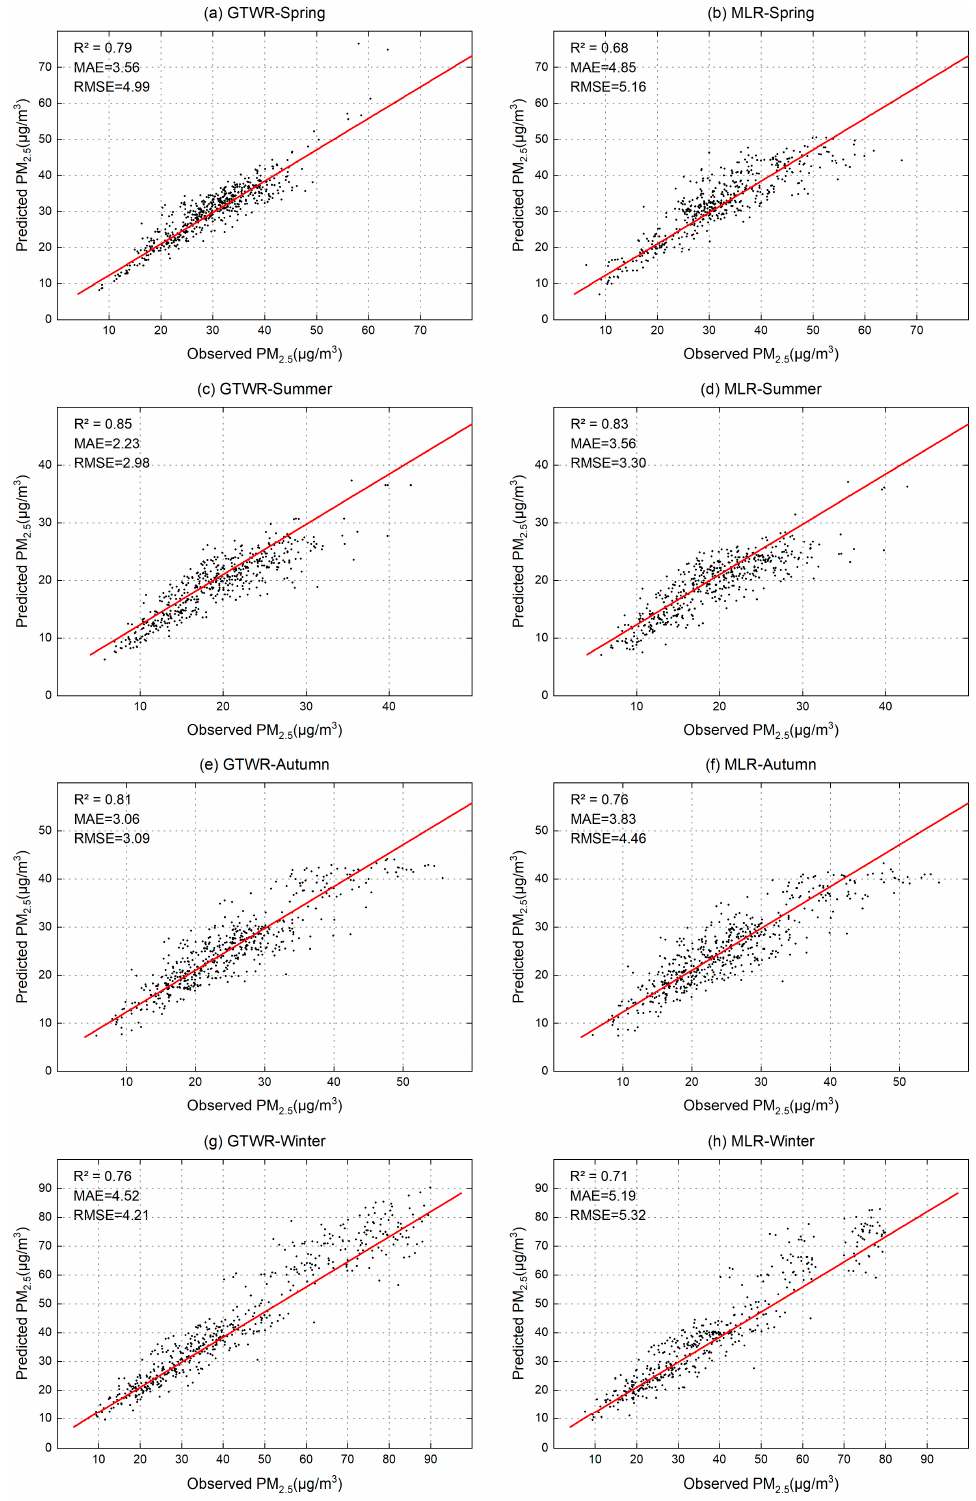
Figure 3. Quarterly fitting results of GTWR and MLR models. (( a , c , e , g ) represent the GTWR fitting results for spring, summer, autumn, and winter; ( b , d , f , h ) represent the MLR fitting results for spring, summer, autumn, and winter).